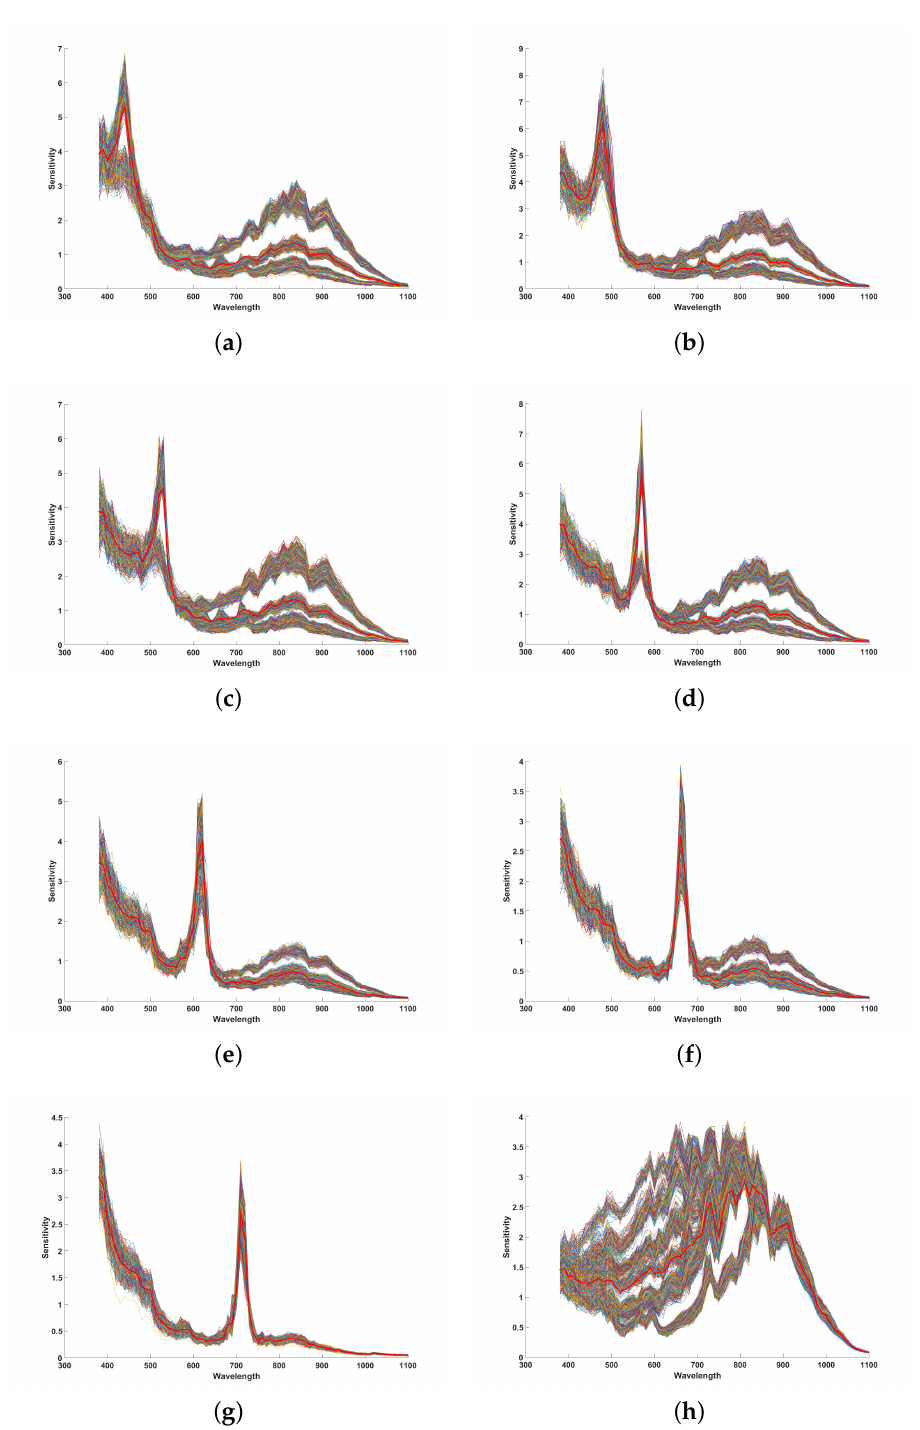
Figure A1. Spectral variation of camera sensitivities over sensor pixels, without applying any pre-processing on the raw images. In red, the average curve per band. ( a ) Sensitivity 1 over pixels; ( b ) Sensitivity 2 over pixels; ( c ) Sensitivity 3 over pixels; ( d ) Sensitivity 4 over pixels; ( e ) Sensitivity 5 over pixels; ( f ) Sensitivity 6 over pixels; ( g ) Sensitivity 7 over pixels; ( h ) Sensitivity 8 over